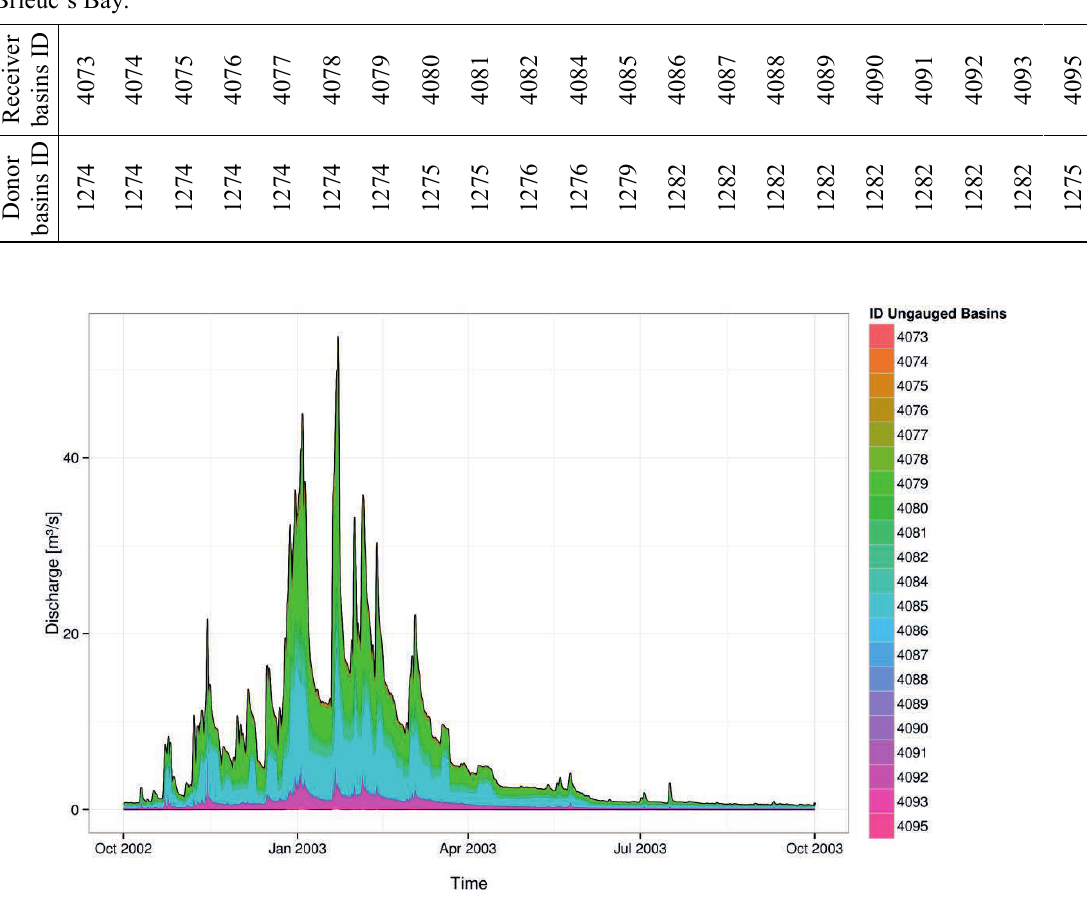
Fig. 3 Total freshwater flowing into the bay of Saint-Brieuc at hourly time